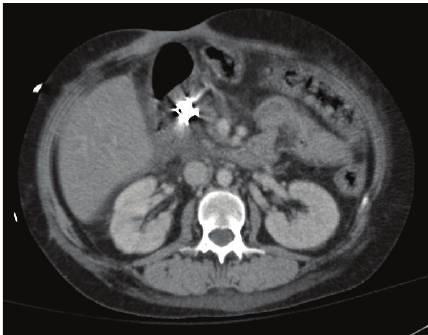
Figure 2: Enteric orifice of the fistula suctioned inside the cap of the Bear Claw with the guide wire still inside the fistula locating in the center.